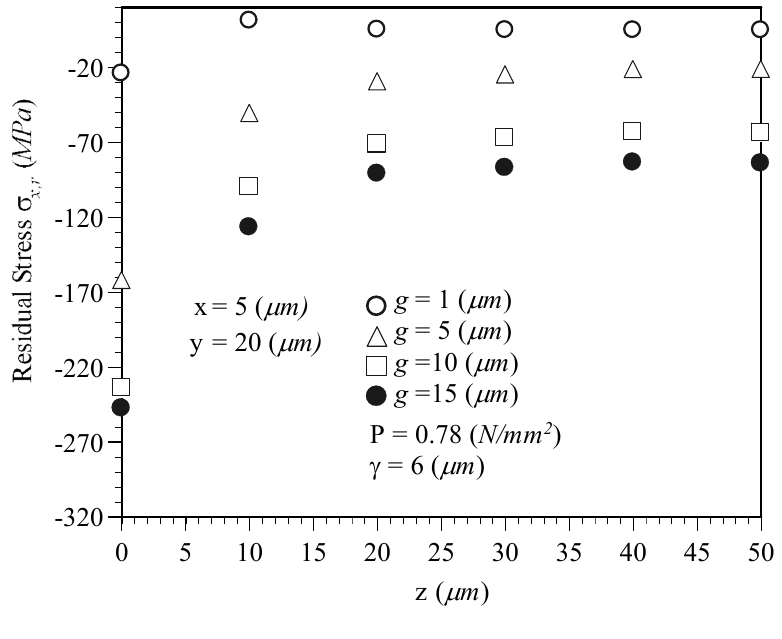
Figure 6. Residual stress σ distribution on the top surface of x,r the microcantilever beam along the z-axis for various contact gaps.